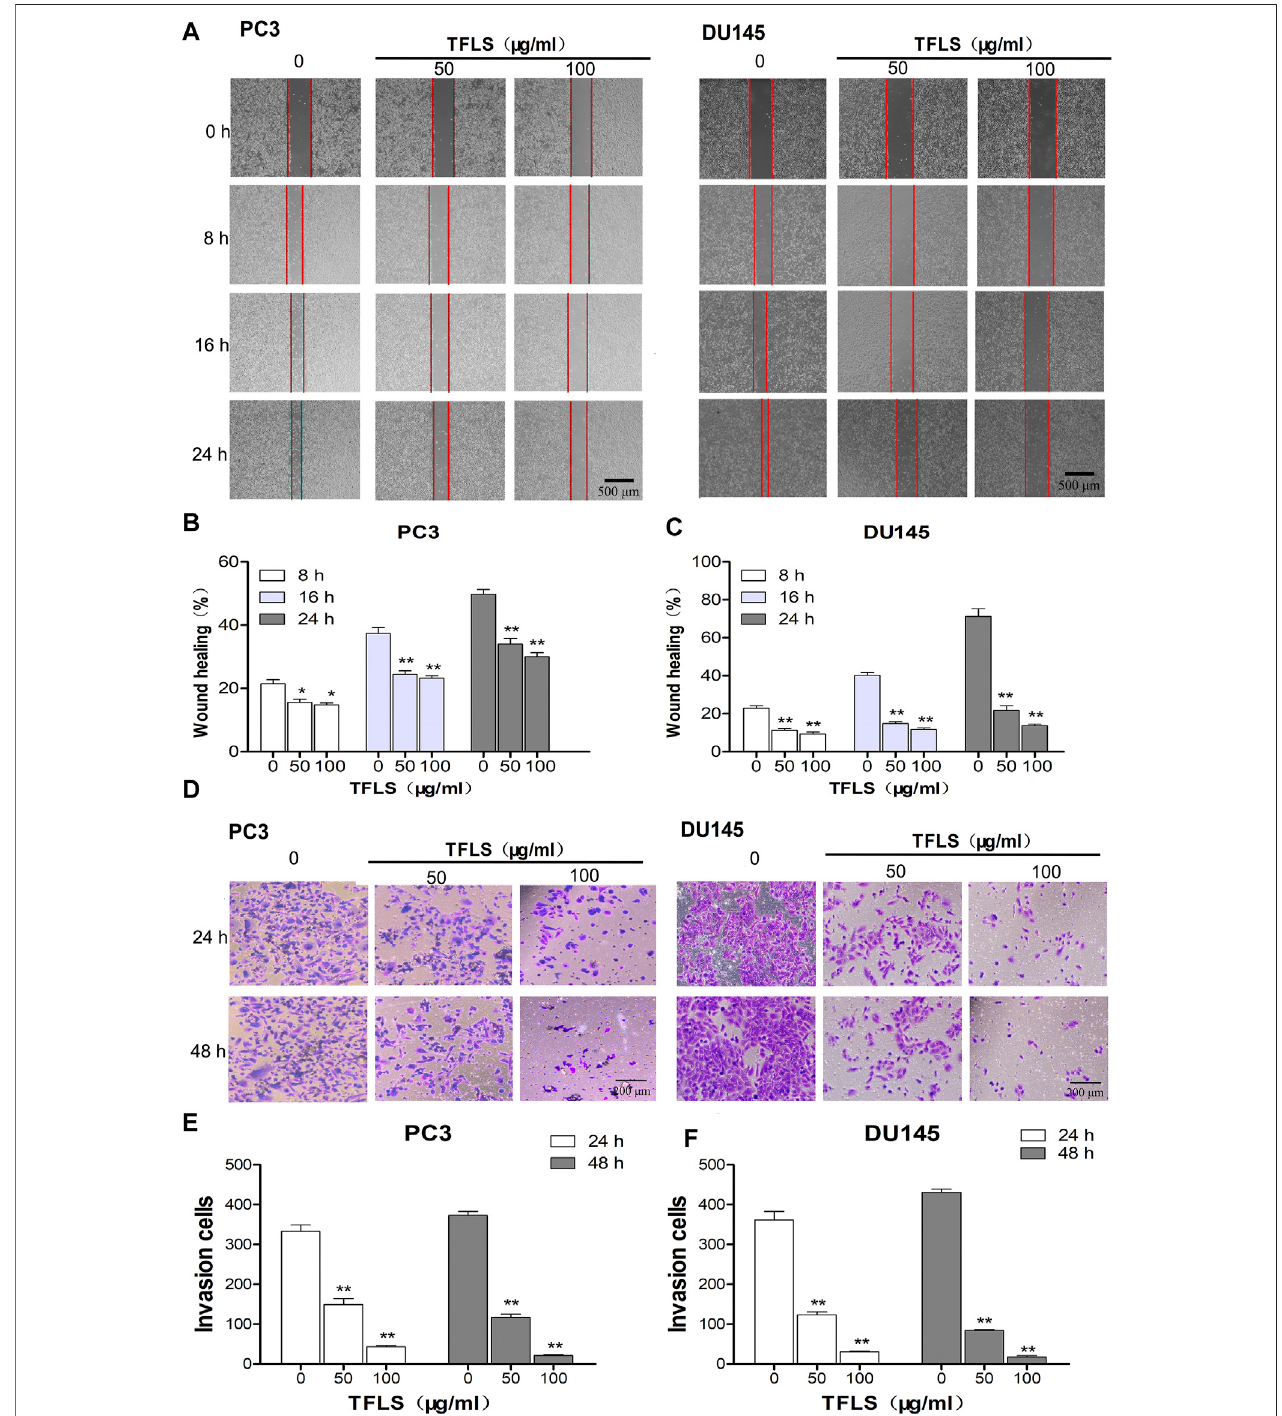
FIGURE5| TFLSinhibitedthemetastasisofPCacells. (A) TheeffectsofTFLSonthemigrationofPC3andDU145cellswereanalyzedusingwound-healingassay. (B,C) Quantitative analysis of average wound healing degrees of PC3 and DU145 cells. (D) Invasiveness of PC3 and DU145 cells that underwent TFLS treatment determinedbytranswellinvasionassay. (E,F) InvadedPC3andDU145cellswerequanti fi ed;Dataareexpressedasmean ± SEM,comparedwiththecontrolgroup:* p < 0.05; ** p < 0.01.